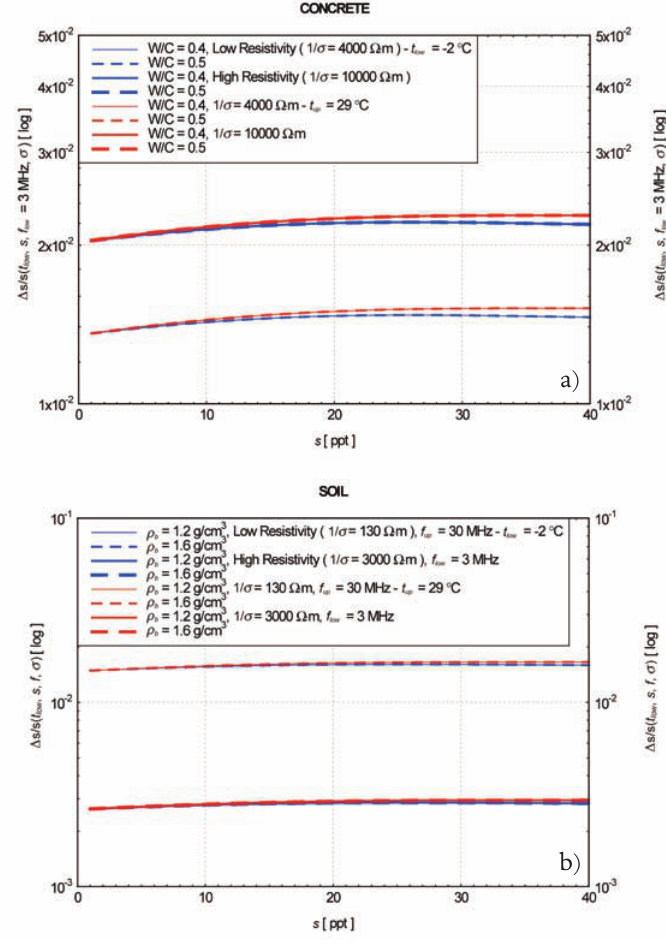
Figure 4. Operating conditions are described in the captions of Figures 1 and 3. Semi-logarithmic plots of the inaccuracy D s / s ( t function of salinity s, in the range s ! [ s ppt, for both concrete (a) and terrestrial soil (b).